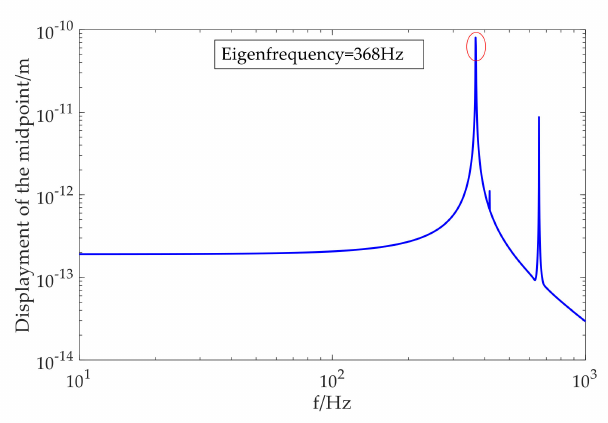
Figure 6. Simulation frequency response of cuboid-type hydrophone in range 10–1000 Hz.